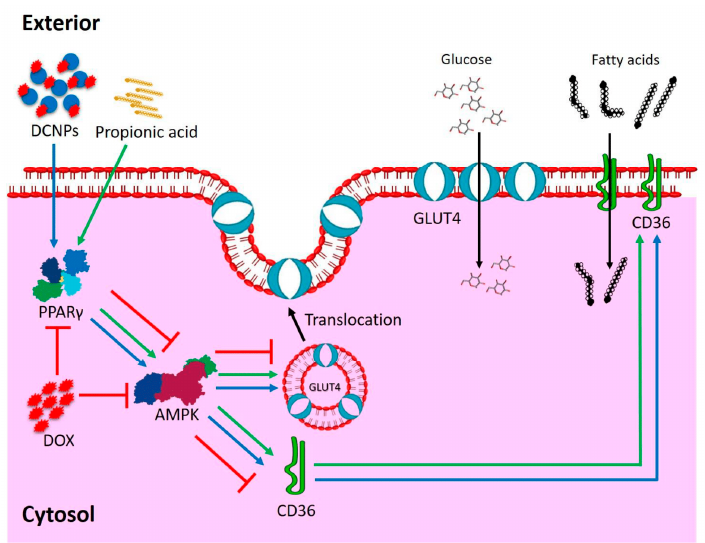
Figure 7. Mechanism—DOX-mediated Cardiotoxicity.